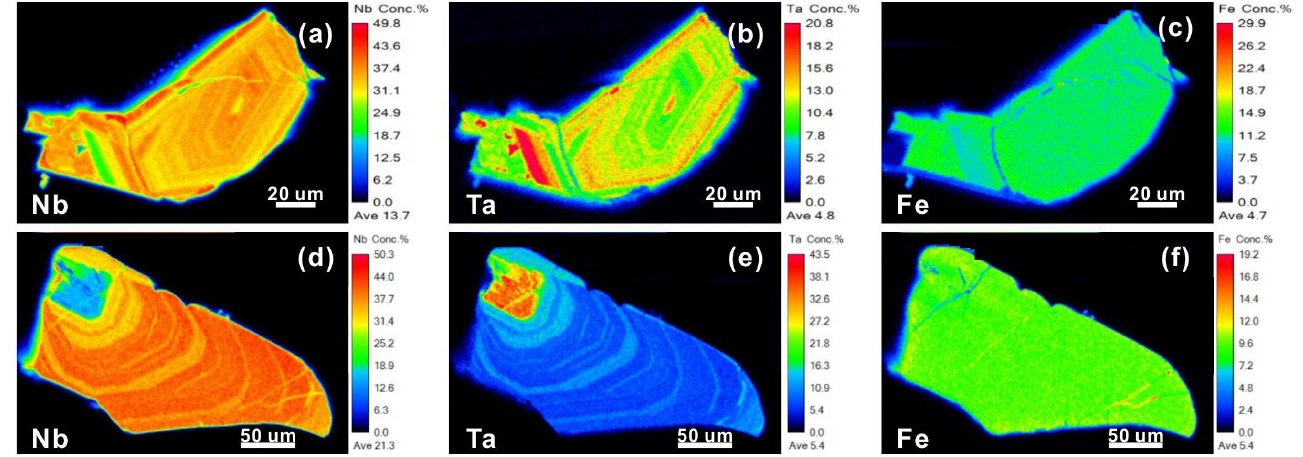
Figure 5. EMPA mapping for the oscillatory CGMs-1 grains. ( a – c ) for grain on Figure 4a and ( d – f ) for grain on Figure 4b.